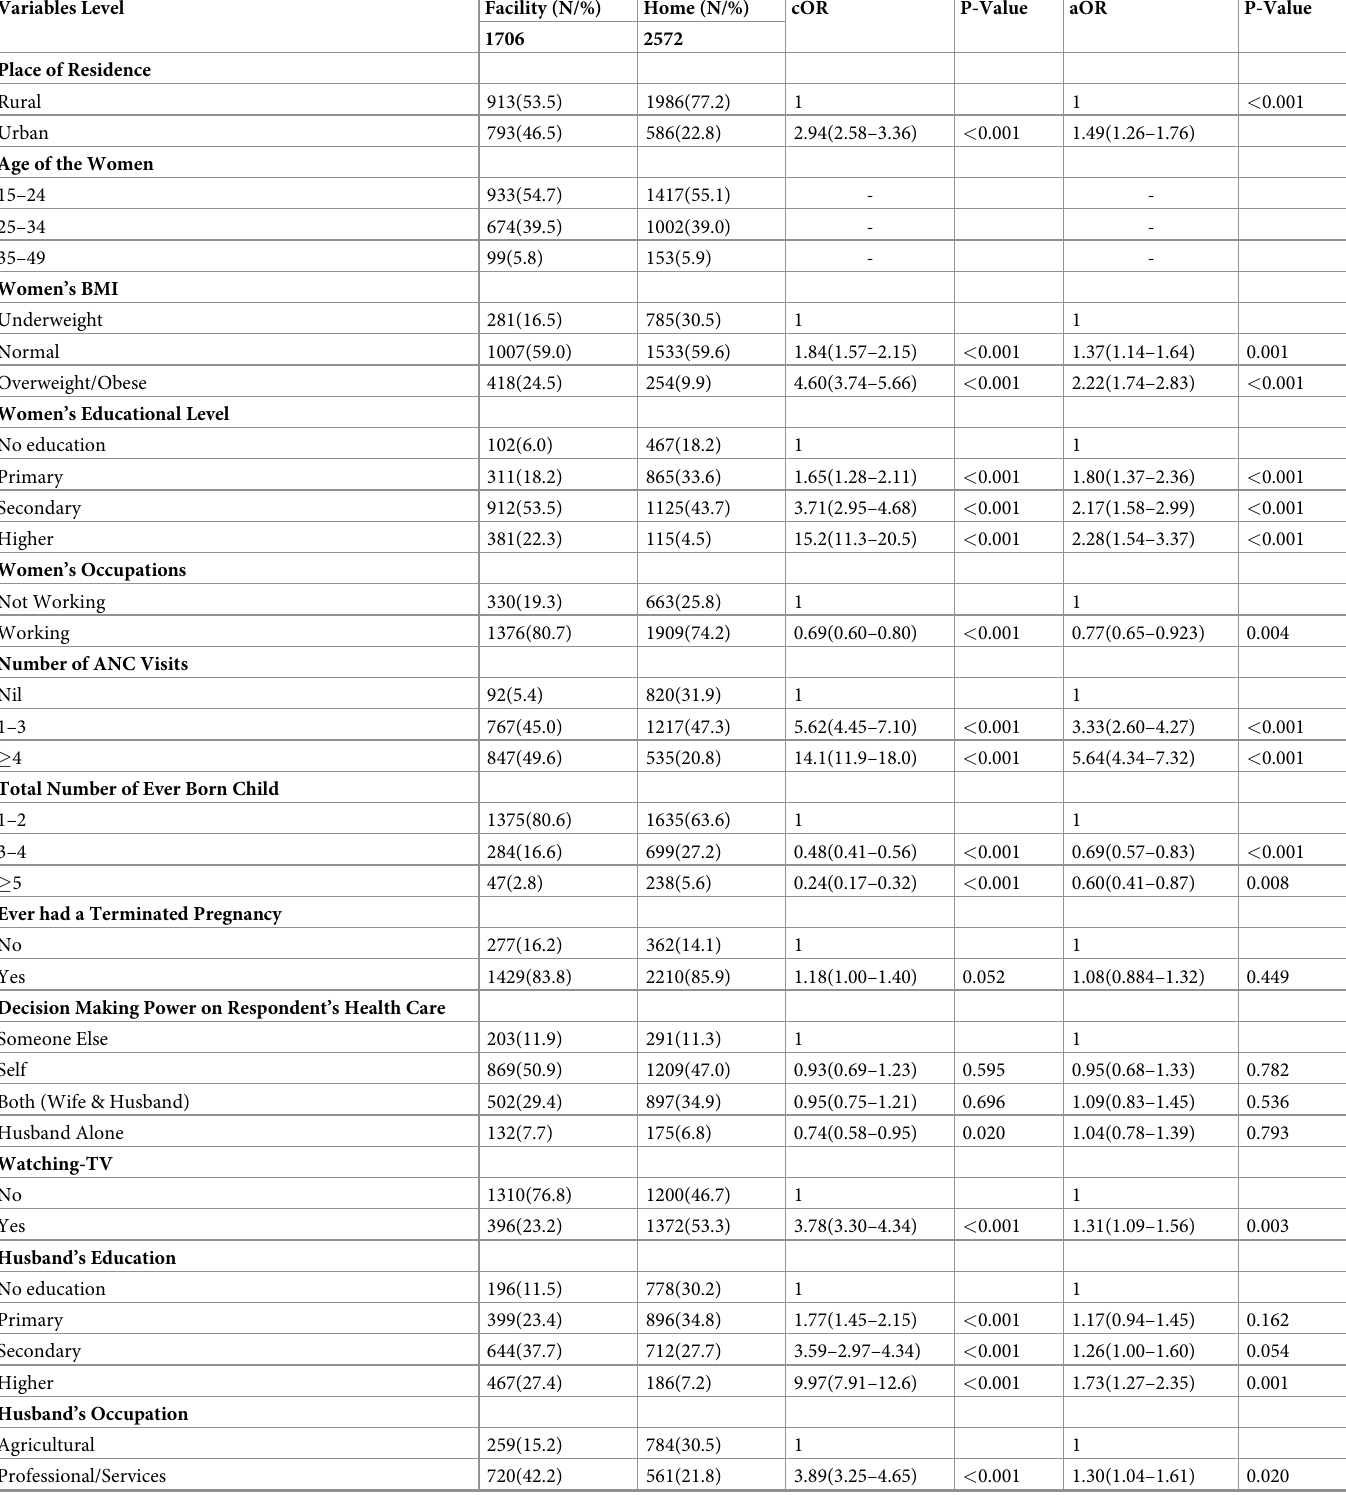
Table 3. Regression results factors associated with health facility delivery by background characteristics: BDHS